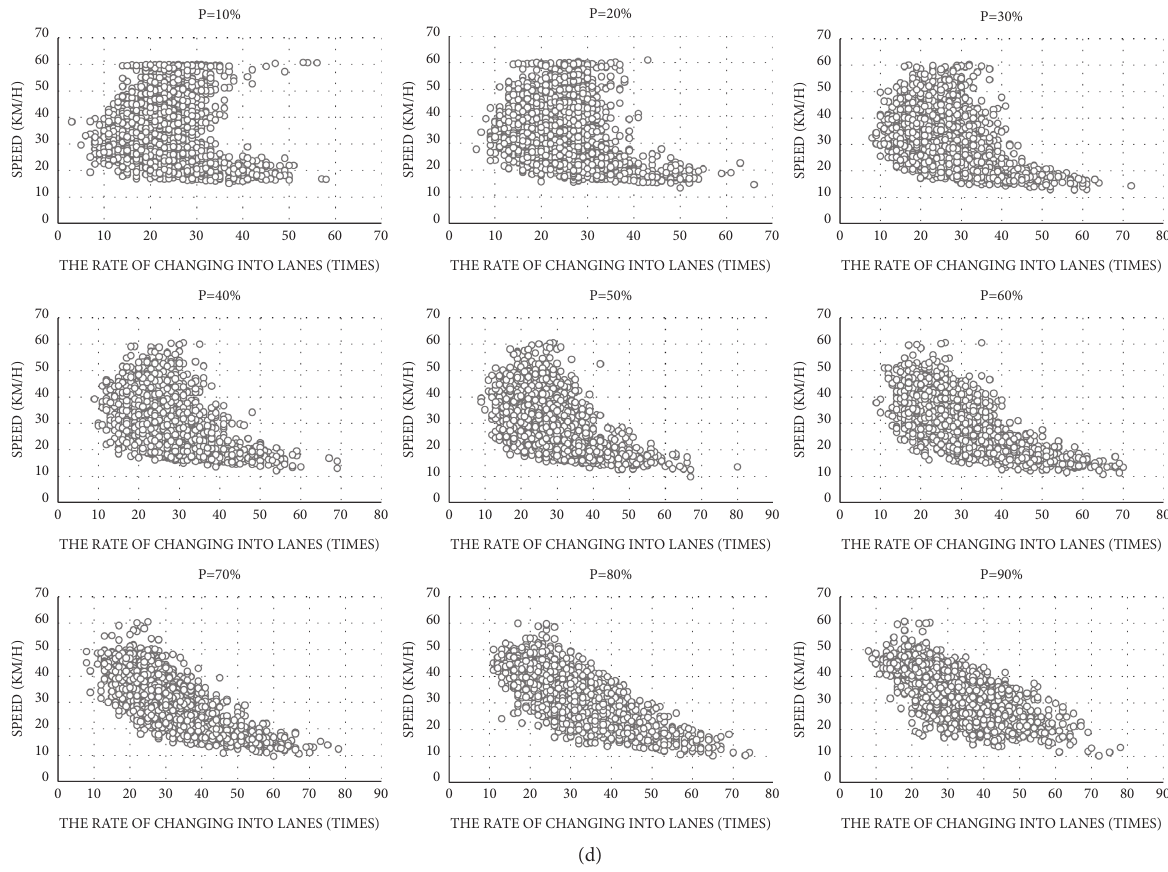
Figure 9: Scatter plot of the relationship between speed and the rate of changing into lanes. (a) A scatter plot of Lane 1. (b) A scatter plot of Lane 2. (c) A scatter plot of Lane 3. (d) A scatter plot of Lane 4.